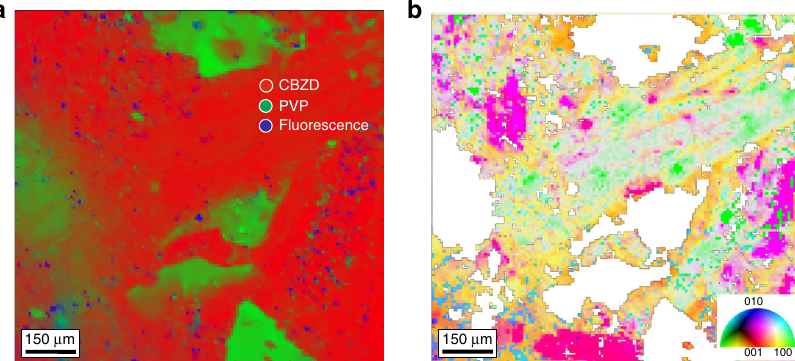
Fig. 4 2D-SAROM for a compacted tablet. a Chemical map obtained from the surface of a compacted tablet containing CBZD and PVP (2:1), b 2D-SAROM map showing the random orientation of CBZD particles on the surface of the tablet. The colors refer to the orientations as de fi ned by the inverse pole fi gure (bottom right). SAROM was performed at a step size of 8 µ m, map dimension 134 × 134 pixels or 1072× 1072 µ m, exposure time per step was 150 ms.